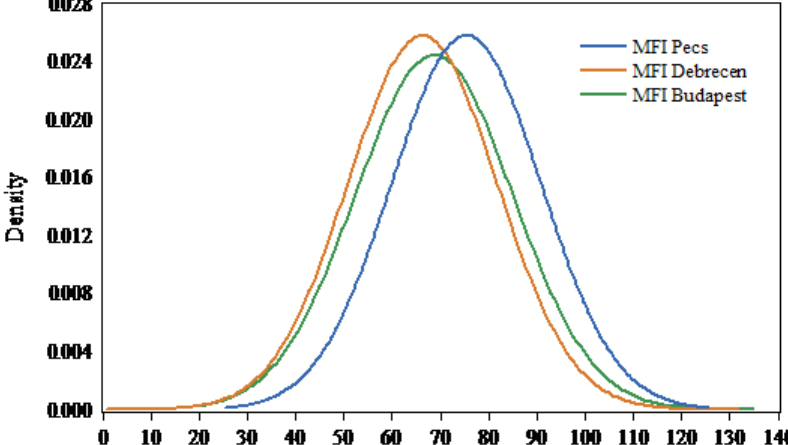
Figure 4. Normal distribution of MFI values for studied stations between 1901 and 2020. Table 7. An overview of MFI values in the three studied stations